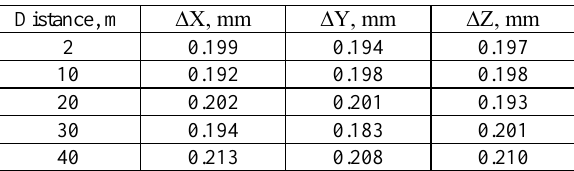
Table 1. Shift values estimated at different photographing